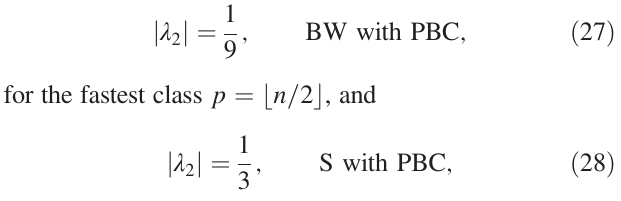
3 Þ 1 with three gates, i.e.,